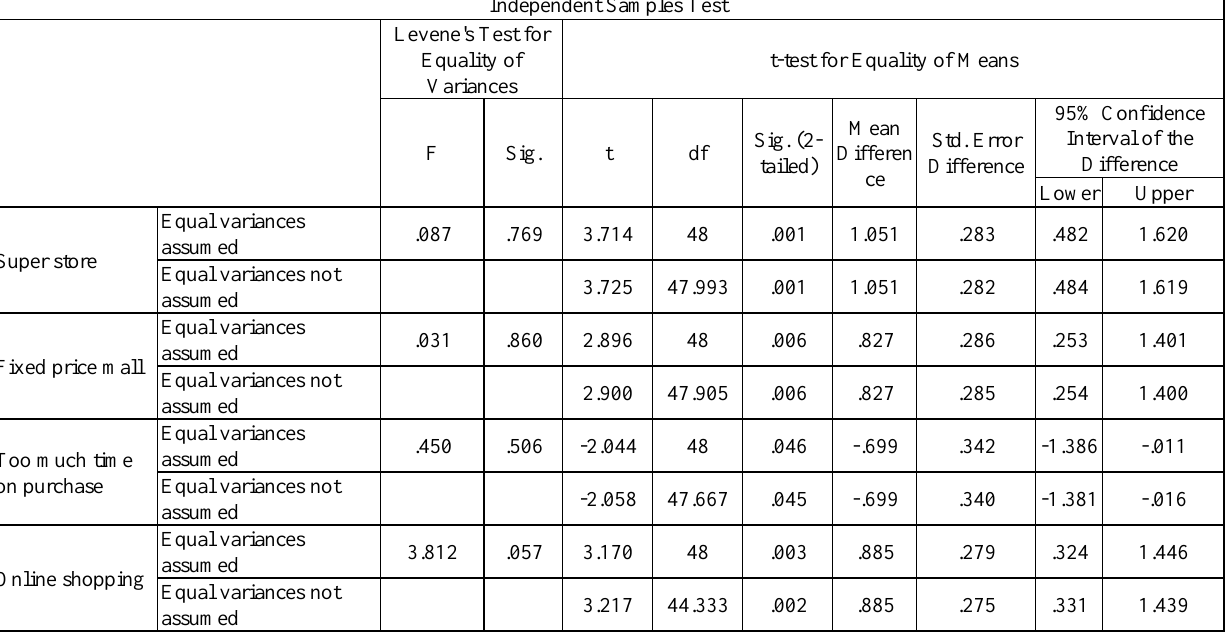
Table 3. Sample Test of the Variables (Superstore, fixed price mall, convenience products, time spend, online